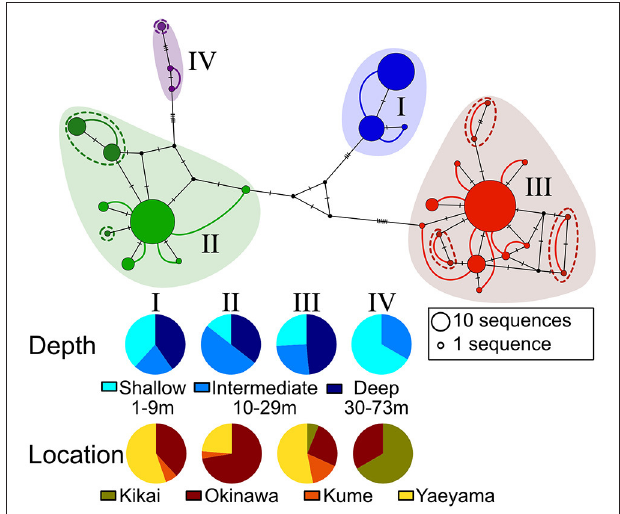
FIGURE 2 | Haploweb made from the Median-Joining haplotype network of the host nuclear ITS2. Colors correspond to the different clusters and size of the circles is proportional to the frequency of the haplotypes. Colored lines indicate haplotypes shared by the same individual and thickness of the lines is proportional to the frequency. Dashed lines indicate small independent clusters that are considered to belong to the larger clusters. Marks on the lines of the haplotype network indicate the number of evolutionary steps between haplotypes.